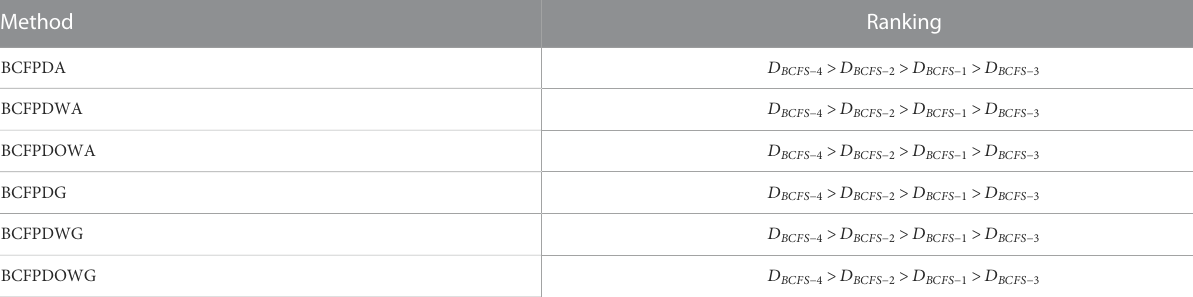
TABLE 6 Ranking order relies on the score values. Method